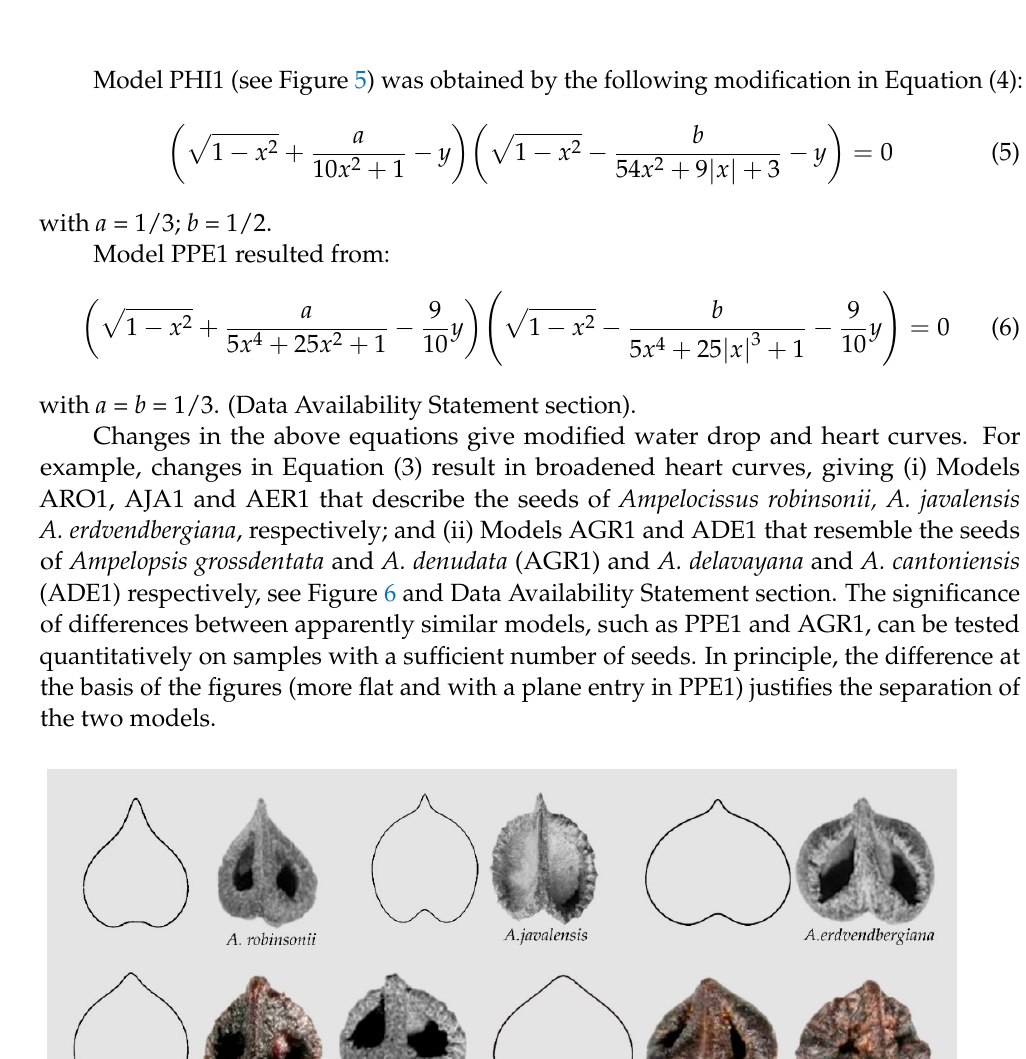
Figure 7. The seeds of many species of Ampelocissus are related with the Squared Heart Curve (SqHC). Model AJA1 adapts well to Ampelocissus cavicaulis , A. macrocirrha and A. ochracea. Model AGR2 represents better the shape of seeds of A. grantii and A. latifolia. 3.2.3. Pear Curves and Other Elongated Models Some seed images resemble water drops in their overall shape; nevertheless, they show broader basis than waterdrops. Figure 8 shows the models YAU1, COL1, VAE1 and AME1 that correspond respectively to the shapes of Yua austro-orientalis and Cissus trianae (YAU1), Cayratia oligocarpa (COL1), Yua chinensis and Vitis aestivalis (VAE1) and Ampelopsis megalophylla (AME1). These four models share similar values of aspect ratio that justify